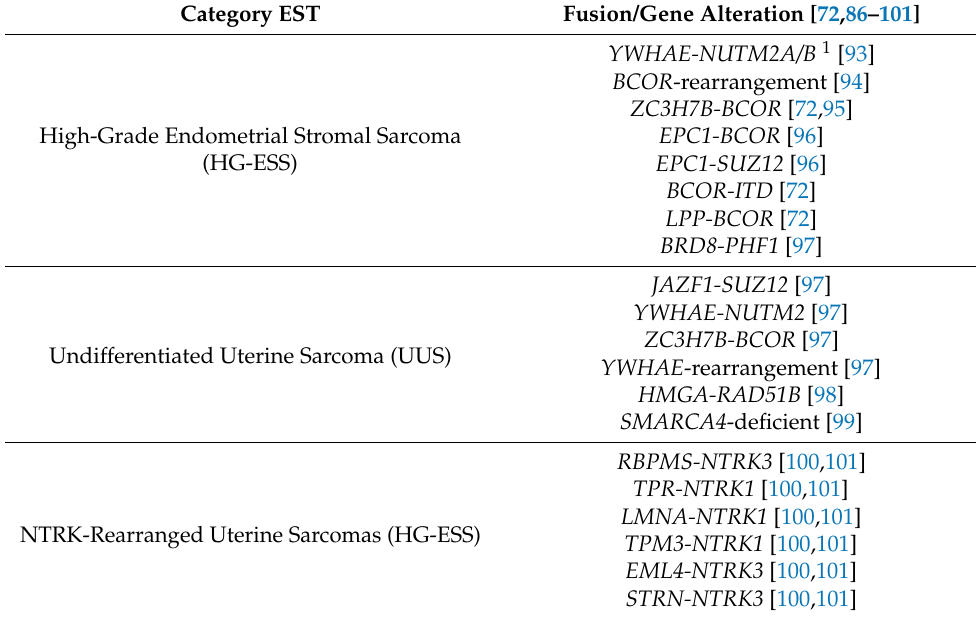
Table 2. Cont. Category EST Fusion/Gene Alteration [72,86–101]